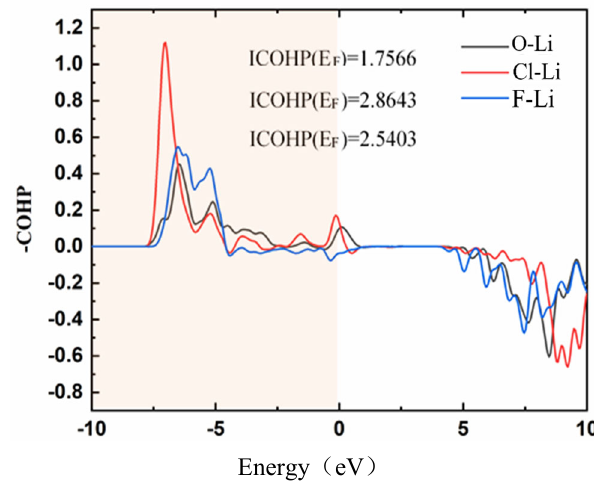
Figure 14. The COHP of O ‐ Li, Cl ‐ Li and F ‐ Li.